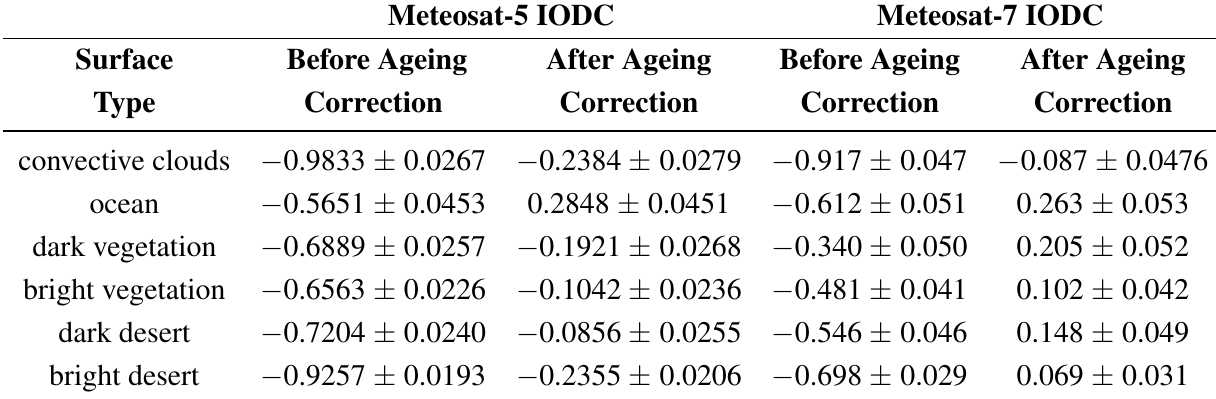
Table 5. The yearly percentage of decrease of the Meteosat-5 and Meteosat-7 IODC time series, before and after ageing